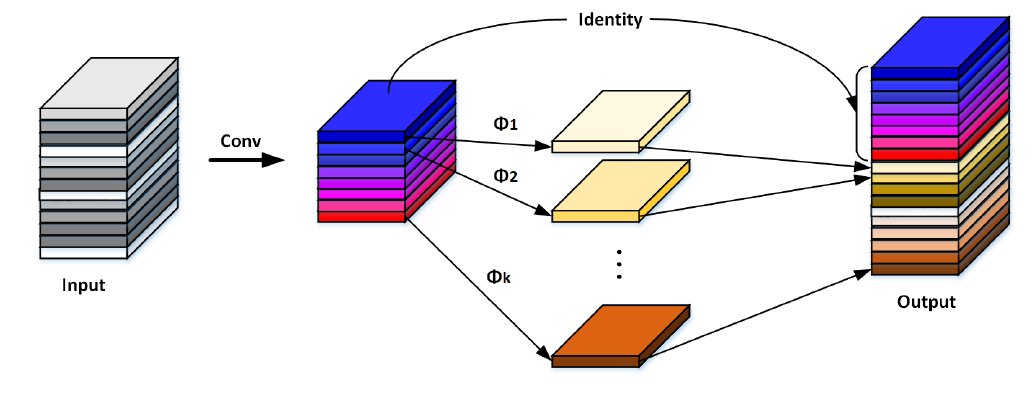
Figure 5. The ghost module.